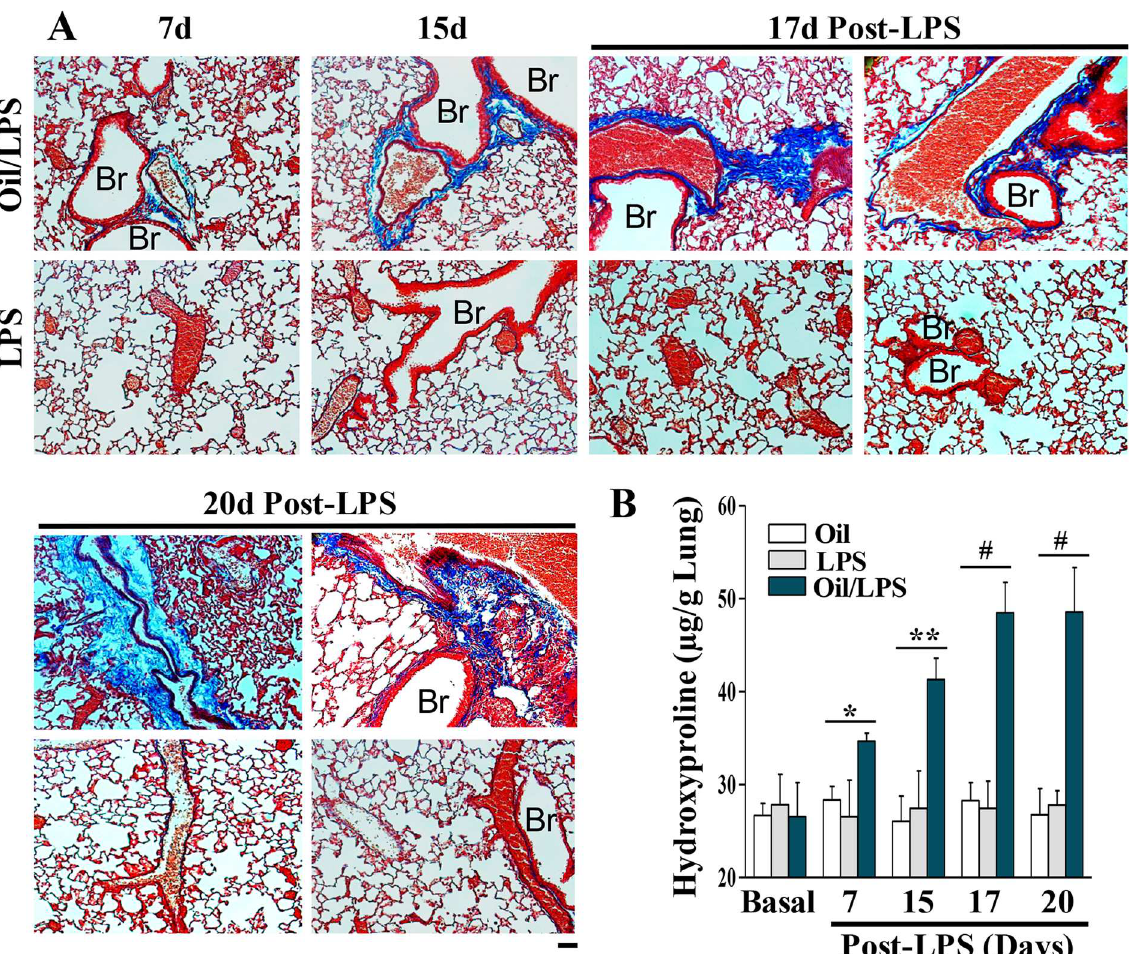
Fig 7. Prominent fibrosis in lungs of oil/LPS-challenged mice. ( A ) Representative micrographs of trichrome staining. Mouse lungs were collectedat the indicatedtimes followingLPS challengefor trichrome staining.Fibrosis (blue) was seen in the adventitia of vessels at 7days post-LPS in oil-loadedmice, which was markedly increasedat day 15 and after. At day 17 and 20 post-LPS challenge,fibrosis was also evidentin the interstitial tissue and peribronchial regions besidesthe adventitia. However, there was no fibrosis in lungs of mice challengedwith LPS alone. Br, bronchiole.( B ) Quantification of lung fibrosis by hydroxyproline assay. Lung tissues were collected at the indicatedtimes for hydroxyproline assay. Data are expressedas mean ± SD (n = 4/group). * , P < 0.05; ** , P < 0.01; #, P <